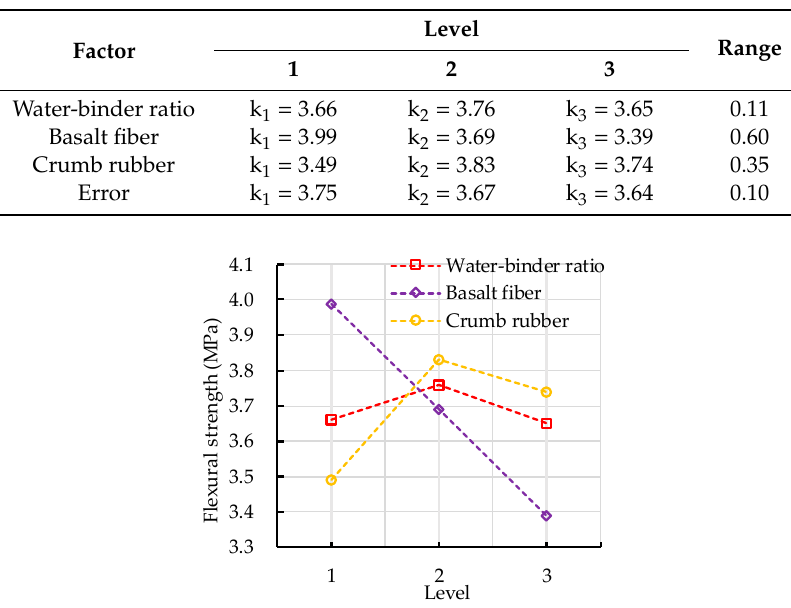
Figure 6. Effects of water–binder ratio, basalt fiber content and crumb rubber replacement rate on flexural strength of CRBFC.